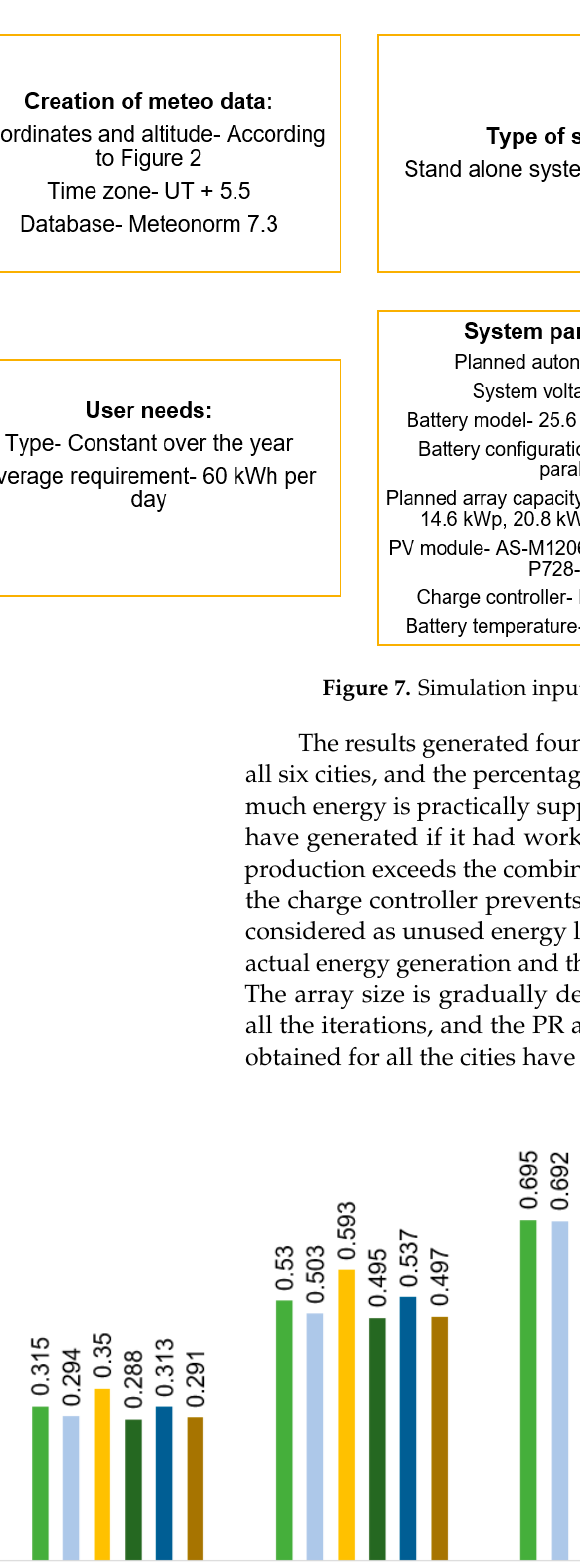
Figure 9. Annual unused energy for different array capacities in all six cities . The highest PR for all cities is achieved with a 9.8 kWp array. For all cities, the losses due to unused energy are the least for the 8.1 kWp array, and the PR is also significantly high. Therefore, the 8.1 kWp array is selected for carrying out further analyses. The MPPT charge controller for this system is selected according to the new array size. The final technical details of the proposed system are given in Table 5, and its elec- trical layout is shown in Figure 10.